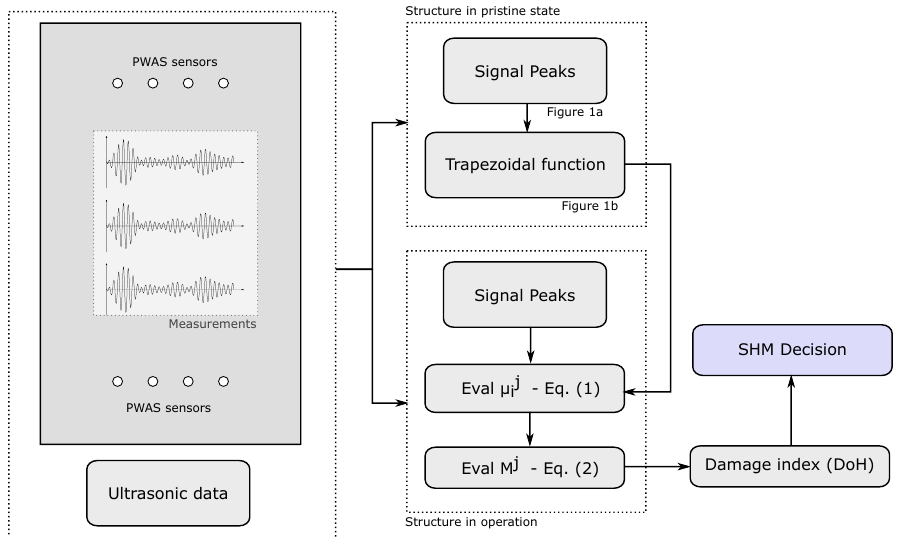
Figure 2. Schematic workflow of the methodology divided between the data acquisition of ultrasonic data and its post-processing depending on the actual structural state (i.e., pristine or in